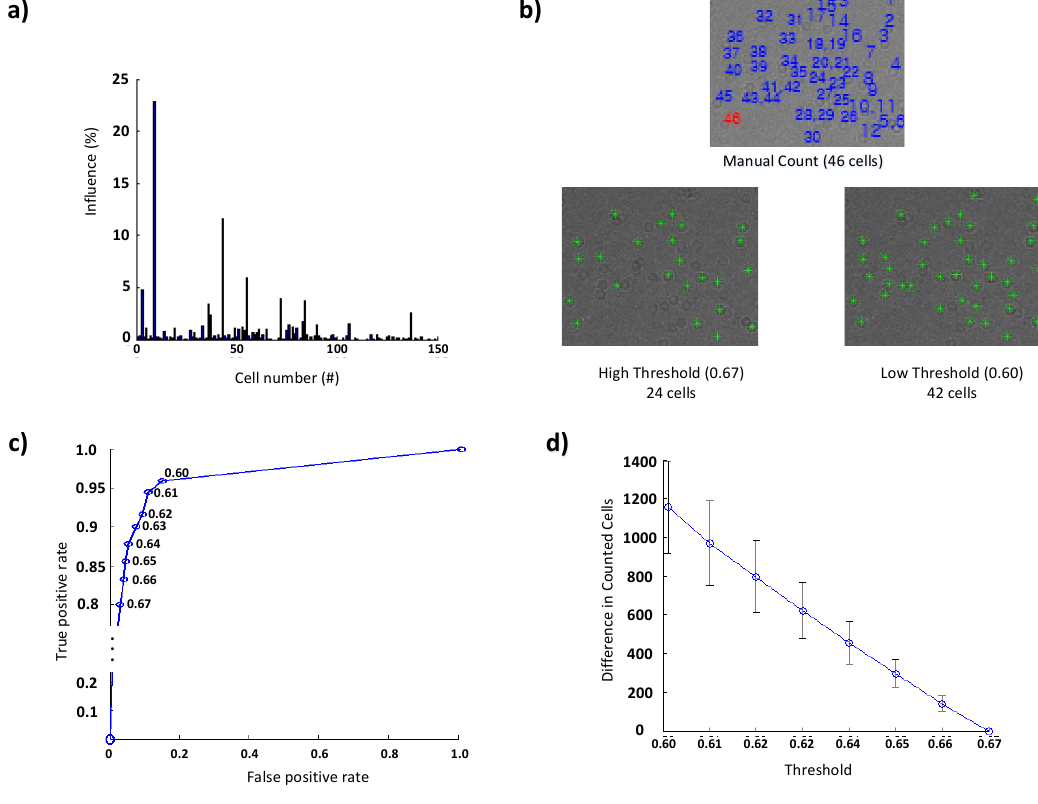
losses from the library; and then (ii) adjusts the threshold to counter these losses. Figure 3. Cell library optimization to avoid inefficiency caused by random construction of the library. ( a ) The influence (%) indicates the proportion of the cell count of each cell image to the total counting result, which varies significantly from one cell image to another; some cell images cannot find any cells, because all of the cells found by these cell images are already counted by other duplicated and/or similar cell images. ( b ) This loss can further be compensated for by reducing the threshold value, e.g., 24 cells are marked under a high threshold value of 0.67, while 42 cells are identified after decreasing the threshold to 0.60, where the latter is close to the result of manual counting. ( c ) A receiver operating characteristic (ROC) curve plots a true positive rate ( i.e ., the ratio of the count of correct cell detection to the total cell count) vs . a false positive rate ( i.e ., the ratio of the count of false cell detection to the total cell count) by varying the threshold value from 0.60 to 0.67. As shown in the ROC curve, the algorithm becomes less sensitive as the threshold value gets higher, thus resulting in the decreased count of cells. ( d ) The number of counted cells linearly depends on, or is inversely proportional to, the threshold value; decreasing the threshold value increases the number of counted cells. This relationship can be used to adjust the threshold value to counter the loss in counting accuracy after optimizing the